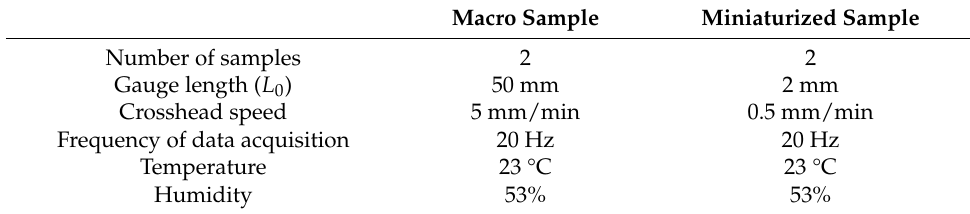
Table 2. Experimental conditions for macro and miniaturized